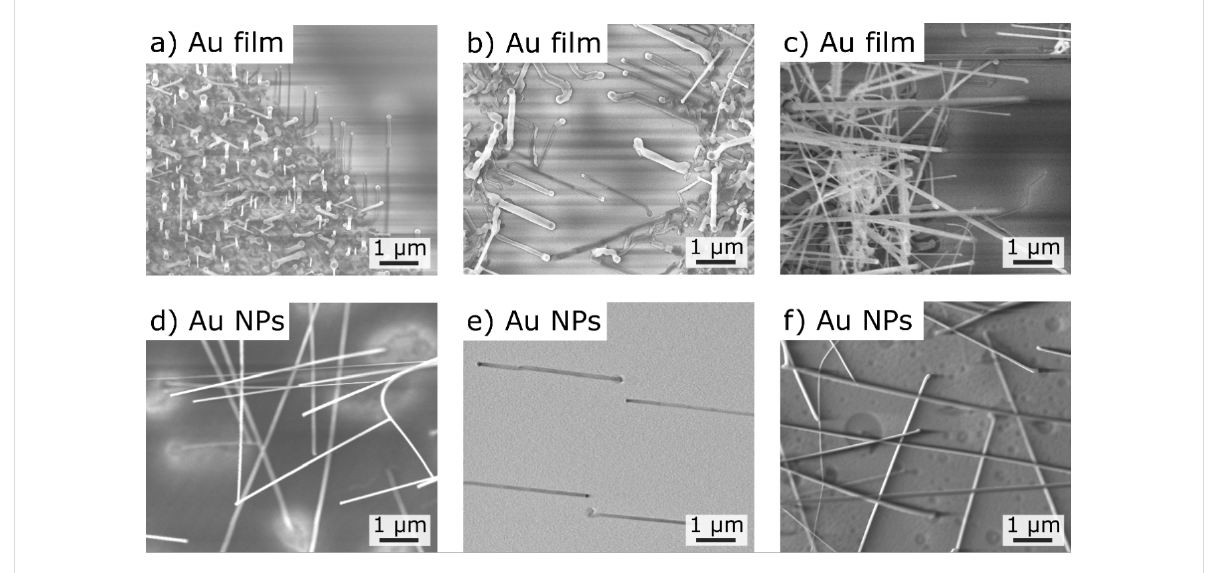
Figure 5: SnO 2 NWs grown on a-plane sapphire substrates at various process pressures and powder temperatures: (a) and (d) 200 mbar and T powder = 950 °C, (b) and (e) 20 mbar and T powder = 950 °C and (c) and (f) 20 mbar and T powder = 1000 °C. Gold film edges ((a), (b) and (c), film thickness 5 nm) and Au NPs ((d), (e) and (f), Ø 80 nm) were used,